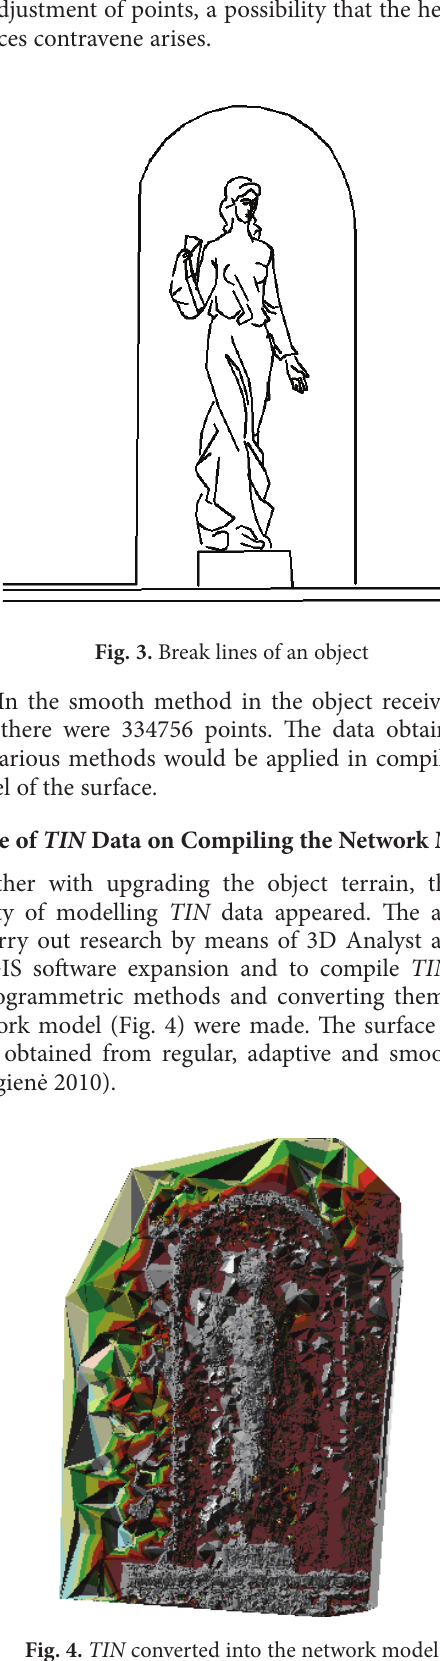
Fig. 4. TIN converted into the network